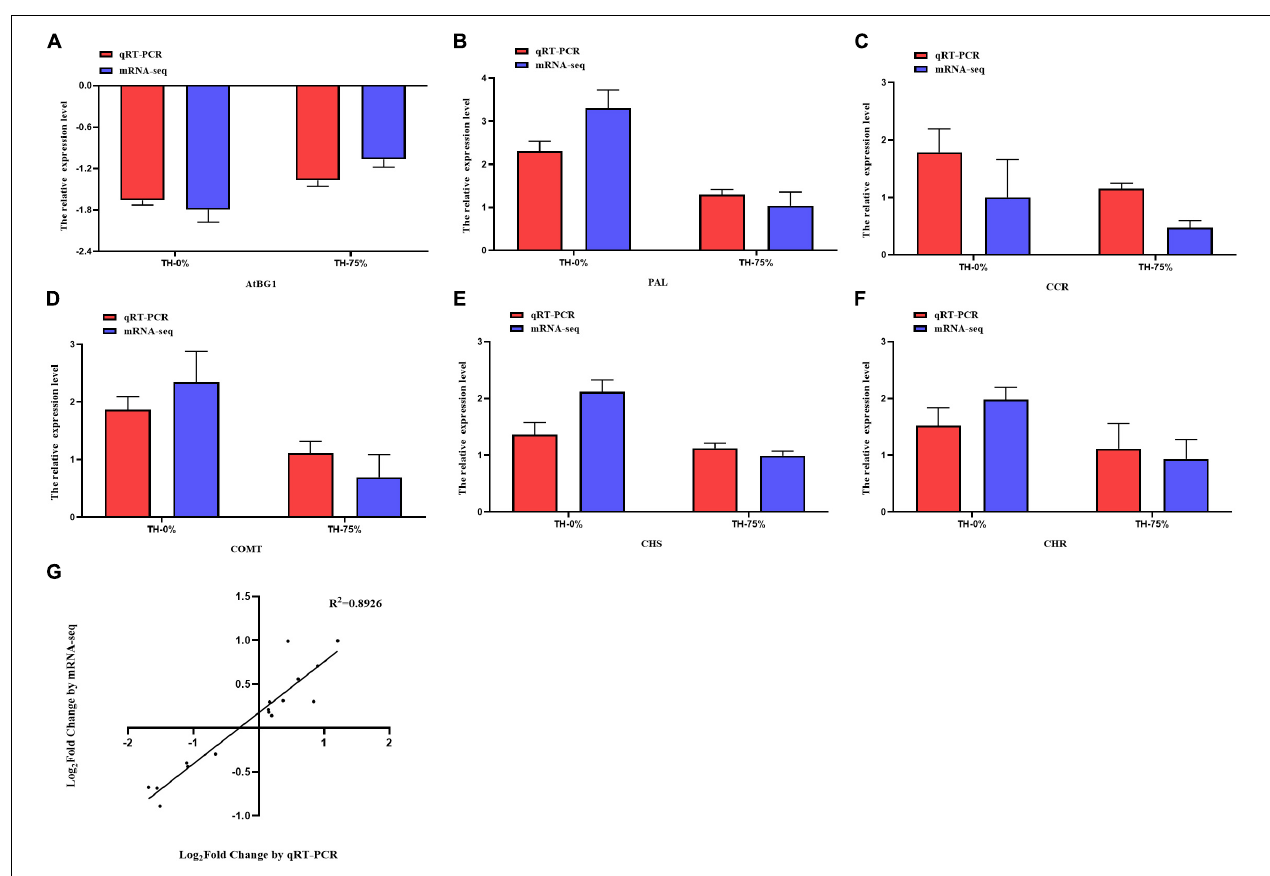
FIGURE 12 | Expression pattern validation (A–F) and linear dependence relation between the log 2 values of the key gene expression ratios obtained from RNA-seq and qRT-PCR